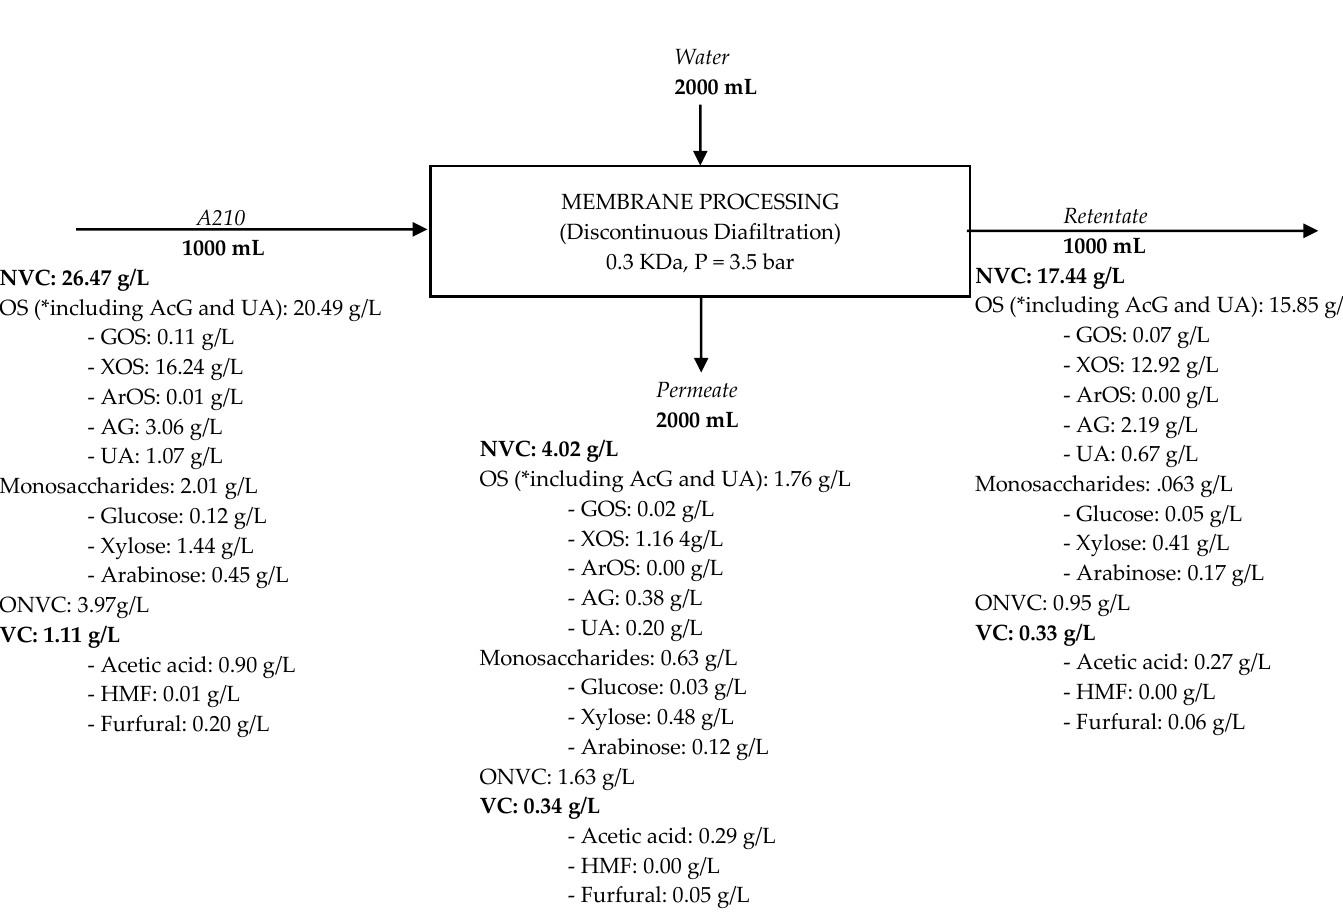
Figure 2. Diagram of membrane processing and composition of the involved streams: AL210, retentate, and permeate.